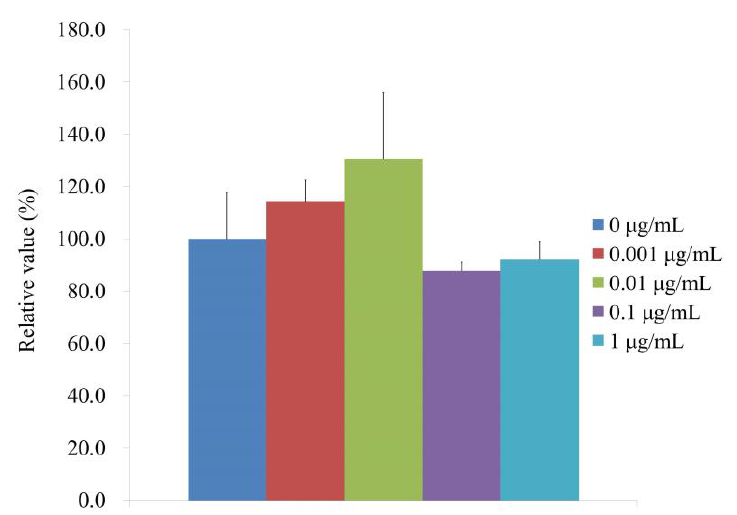
Figure 5. Activity of alkaline phosphatase on Day 7.